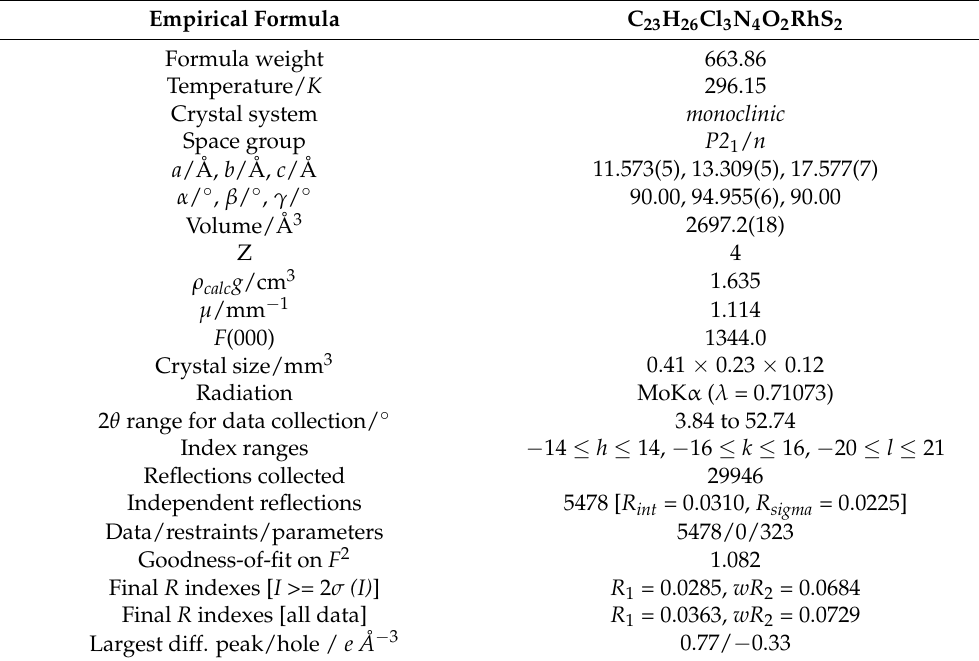
Table 1. Crystal data and structure refinement parameters for the complex 9-PMAH-Rh.